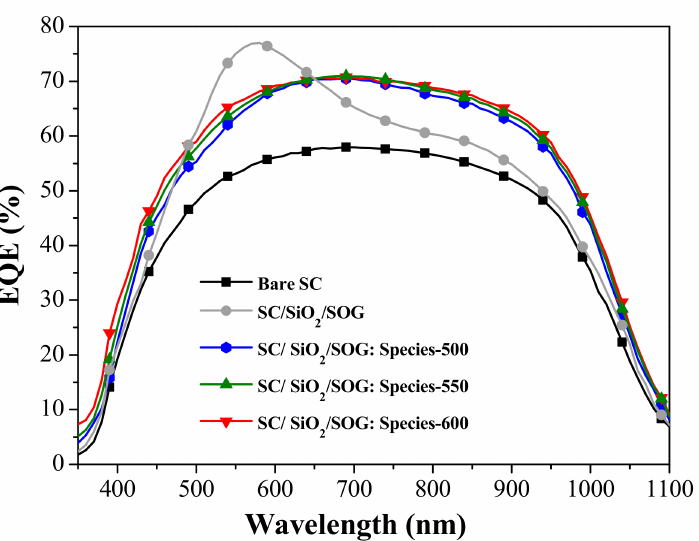
Figure 9. EQE spectra of bare silicon solar cell, cell with spacer/SOG, and cells with spacer/SOG- phosphors (species-500, species-550, and